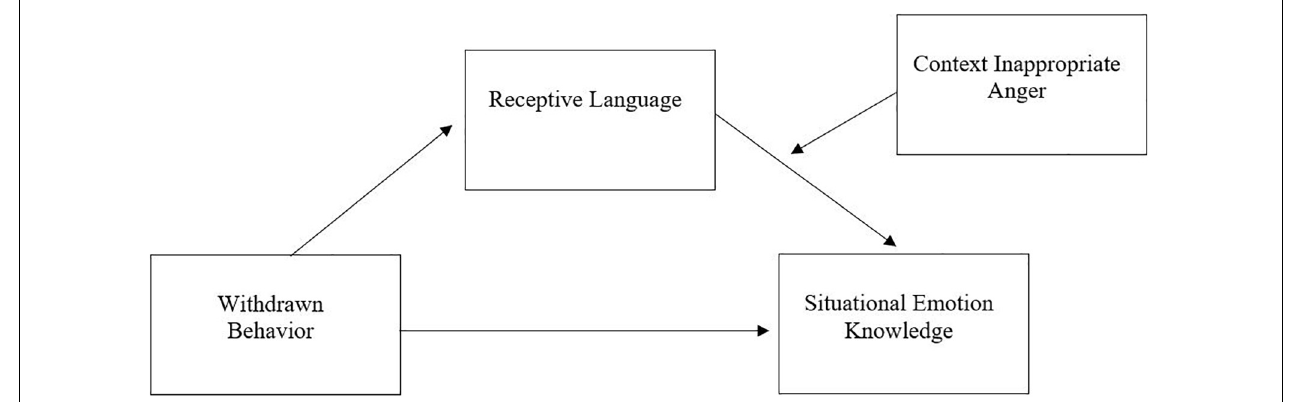
FIGURE 1 | Conceptual model of moderated mediation by CI